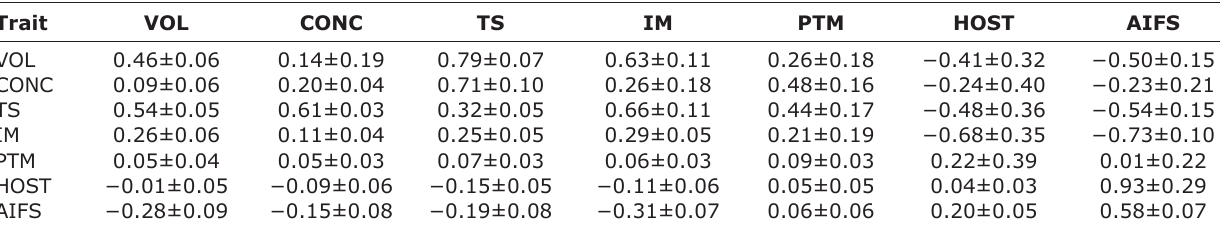
Table-2: Bull effects (Genetic + Permanent environmental correlation; above diagonal values), phenotypic correlation (below diagonal values), and repeatability estimates (diagonal values) of semen traits of Gir bulls.